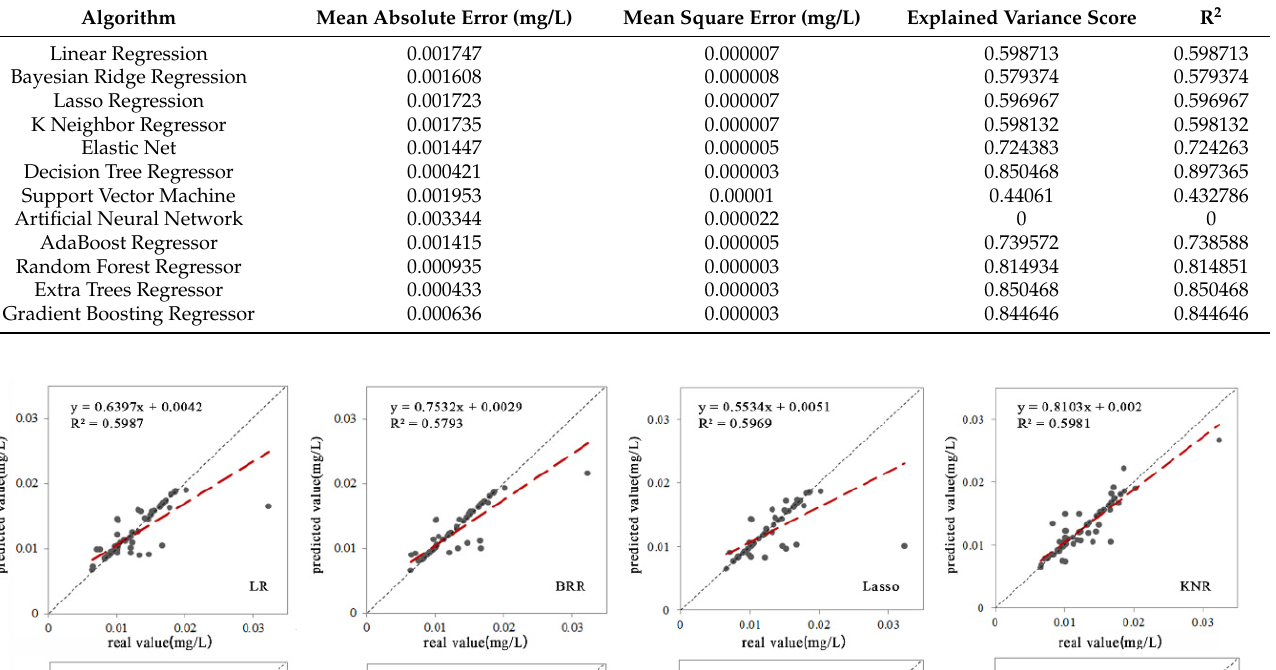
Table 2. The assessment parameters of model performance for the TP concentration.